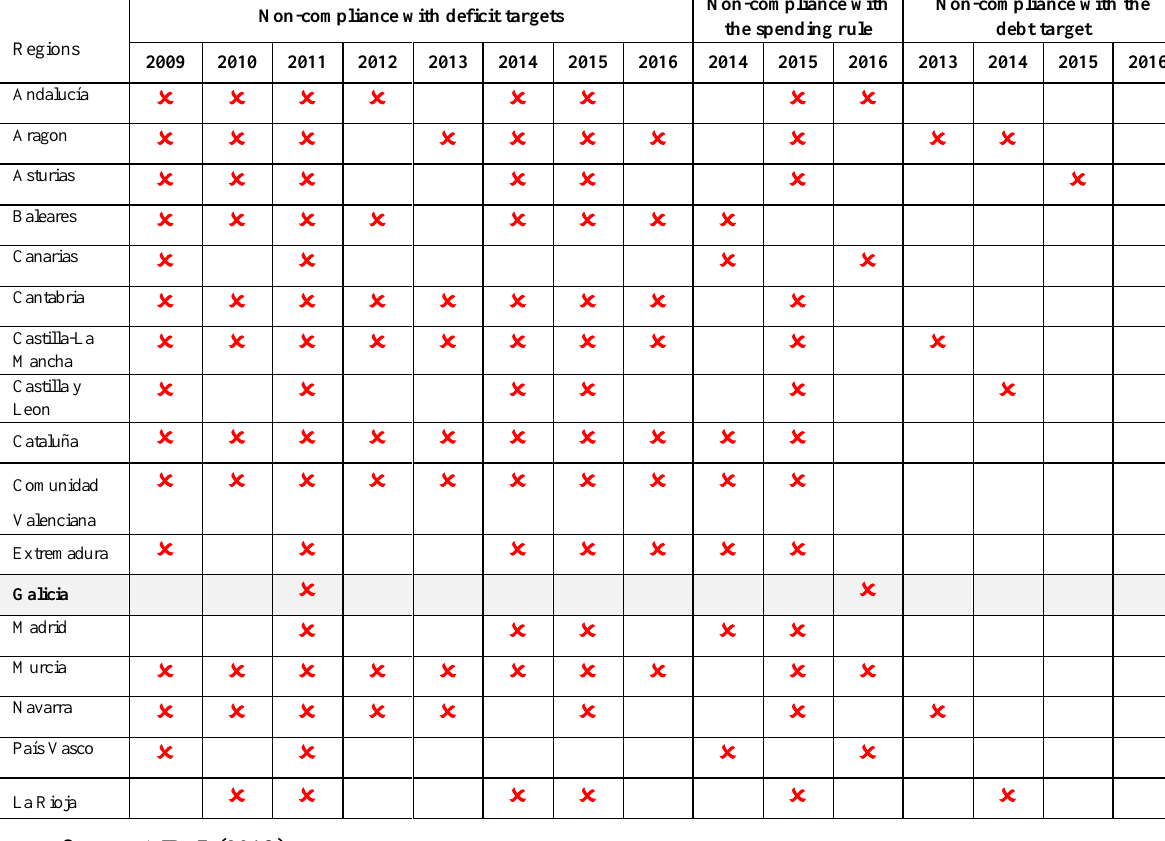
Table 1 : Regional non-compliance with fiscal targets (2009 −